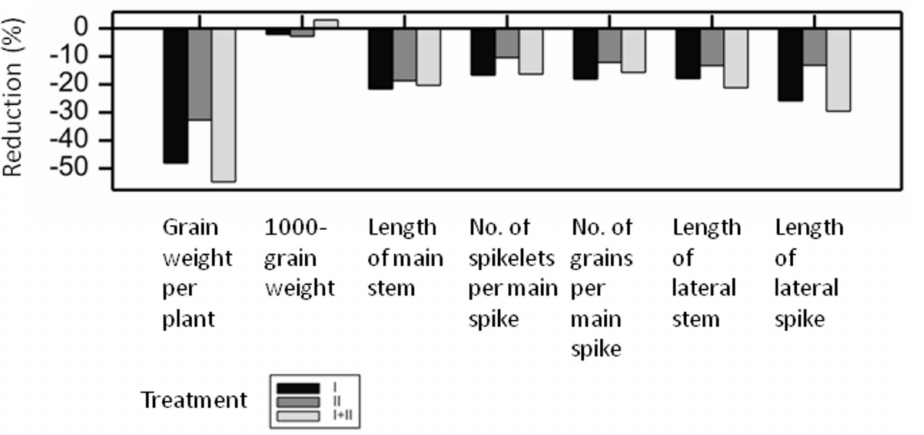
Figure 6. Mean e ff ects of treatment I, II and I + II for phenotypic traits for which no variety-specific e ff ects were observed (expressed in % of mean value under control conditions); for 1000-grain weight the e ff ects were not